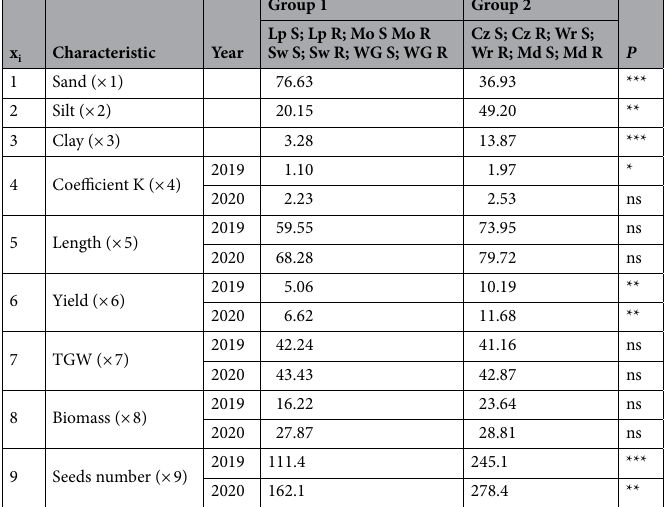
Table 4. The means of winter wheat characteristics and environmental parameters in the two groups of experimental sites according to the k -means analysis. Sites of experiments: Lp Lipnik, Mo Mochełek, Md Mydlniki, Cz Czesławice, Sw Swojczyce, WG Winna Góra, Wr Wrocław. Mixture with (R) resistant, (S) susceptible biotype of blackgrass; TGW thousand-grain weight, K hydrothermal coefficient, P probability, *0.05, **0.01, ***0.001, ns not significant.